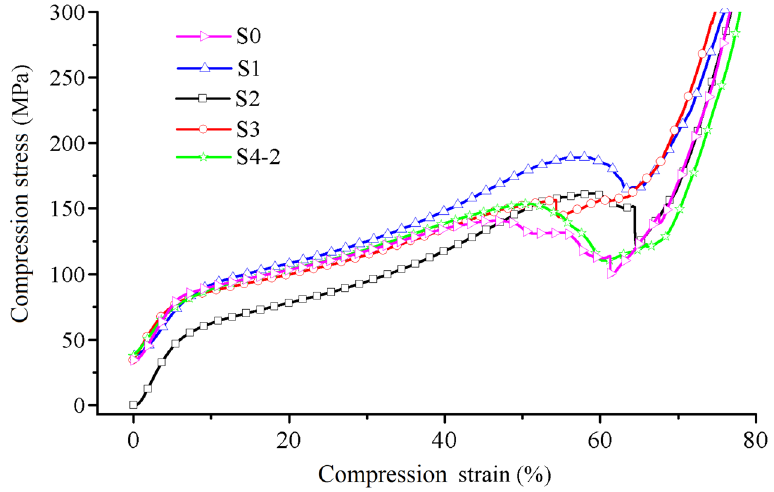
Figure 12. Compression properties of FFF PEEK-PLA/WS/HA